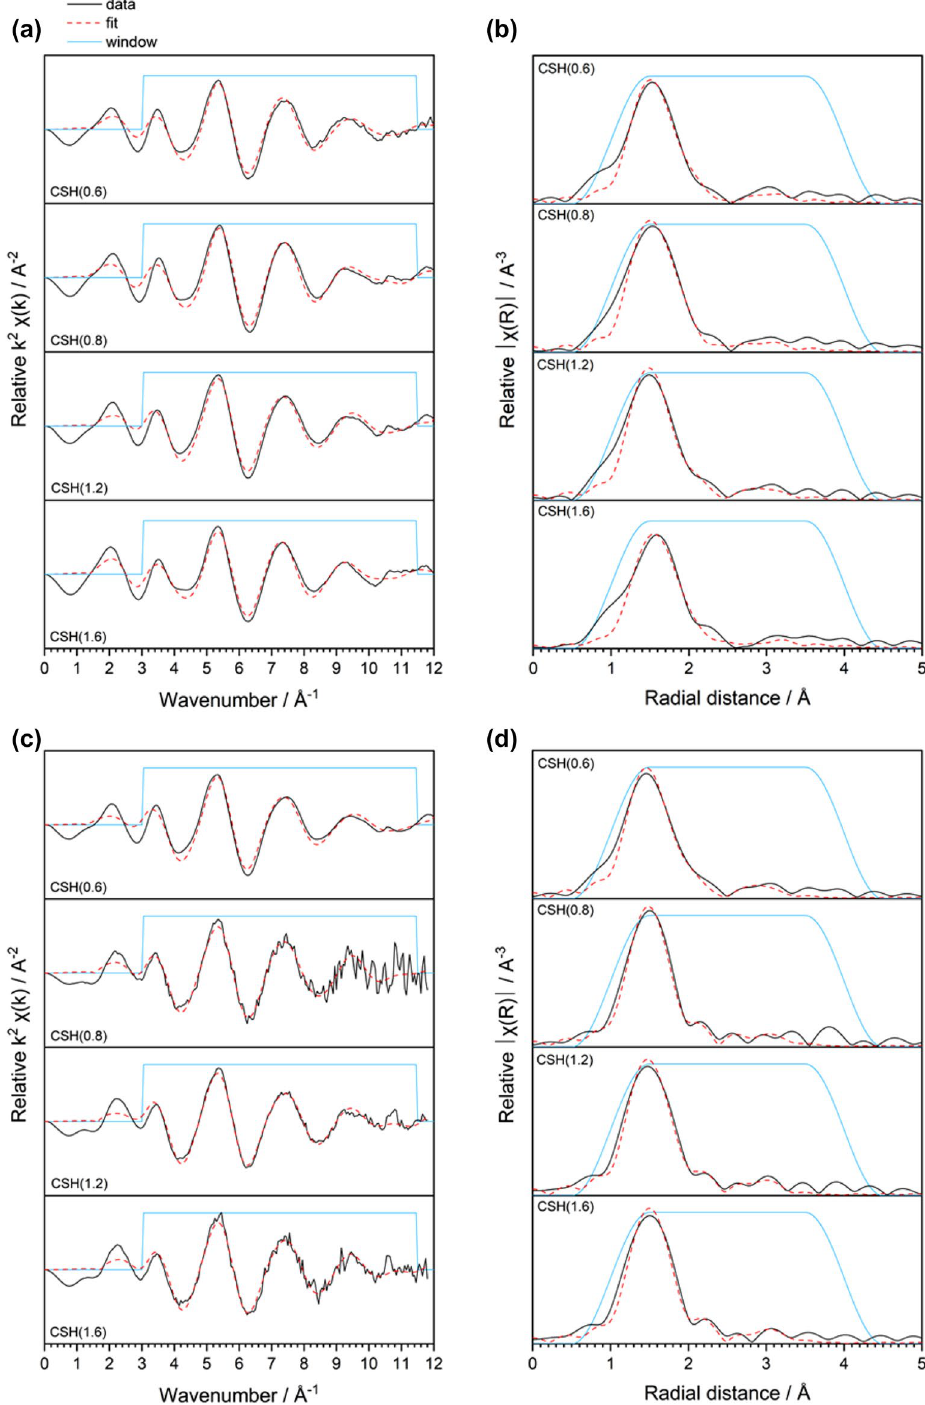
Figure 6. Local coordination analysis of U(VI) in contact with C–S–H phases. ( a ) k 2 -weighted spectra and ( b ) corresponding Fourier transformed radial plots for 0.5 mM U(VI)-contacted C–S–H phases; ( c ) k 2 -weighted spectra and ( d ) corresponding Fourier transformed radial plots for 10 mM U(VI)-contacted C–S–H